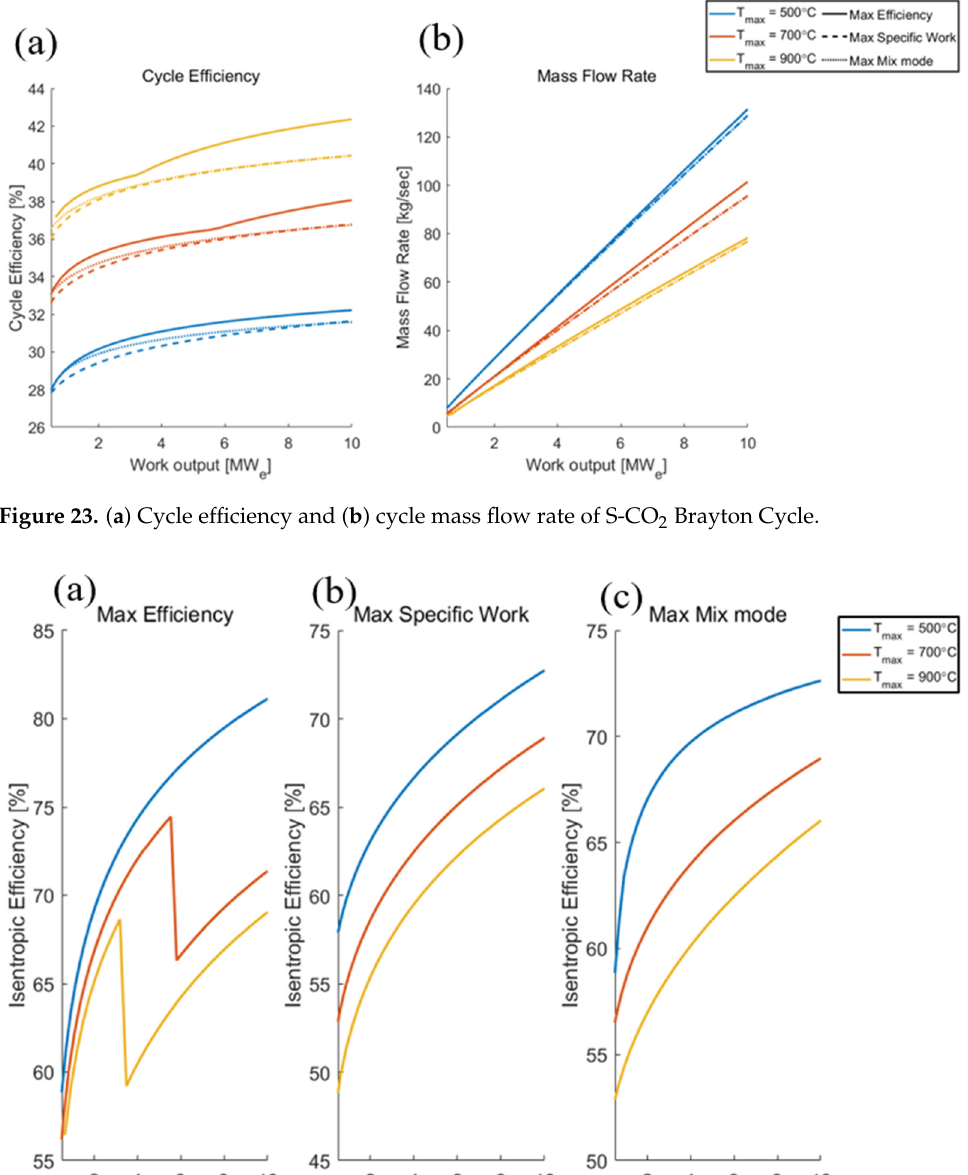
Figure 25. ( a ) Turbine isentropic efficiency, ( b ) Turbine rotor diameter, and ( c ) Rotational speed of S-CO 2 Brayton cycle. Figure 23a shows the S-CO 2 simple recuperated Brayton cycle efficiency over various power output levels. At the cycle maximum temperature of 500 °C with optimization at the maximum efficiency, the cycle efficiency showed a smooth curve. However, at the cycle maximum temperature of 700 °C and 900 °C, the cycle efficiencies with maximum efficiency mode had inflection points at 5.54 MWe and 3.19 MWe, respectively. The reason for the rapid change in the cycle efficiency is the abrupt change in the optimized turbine pressure ratio. At 5.54 MWe, the cycle was optimized at the turbine pressure ratio of 2.15. However, at 5.81 MWe, the cycle was optimized at the turbine pressure ratio of 2.53, as shown in Figure 26. This abrupt change in the optimized turbine pressure ratio causes the